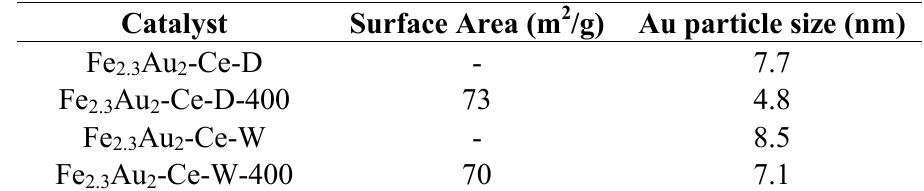
Table 3. Surface area and Au crystal size of Fe different